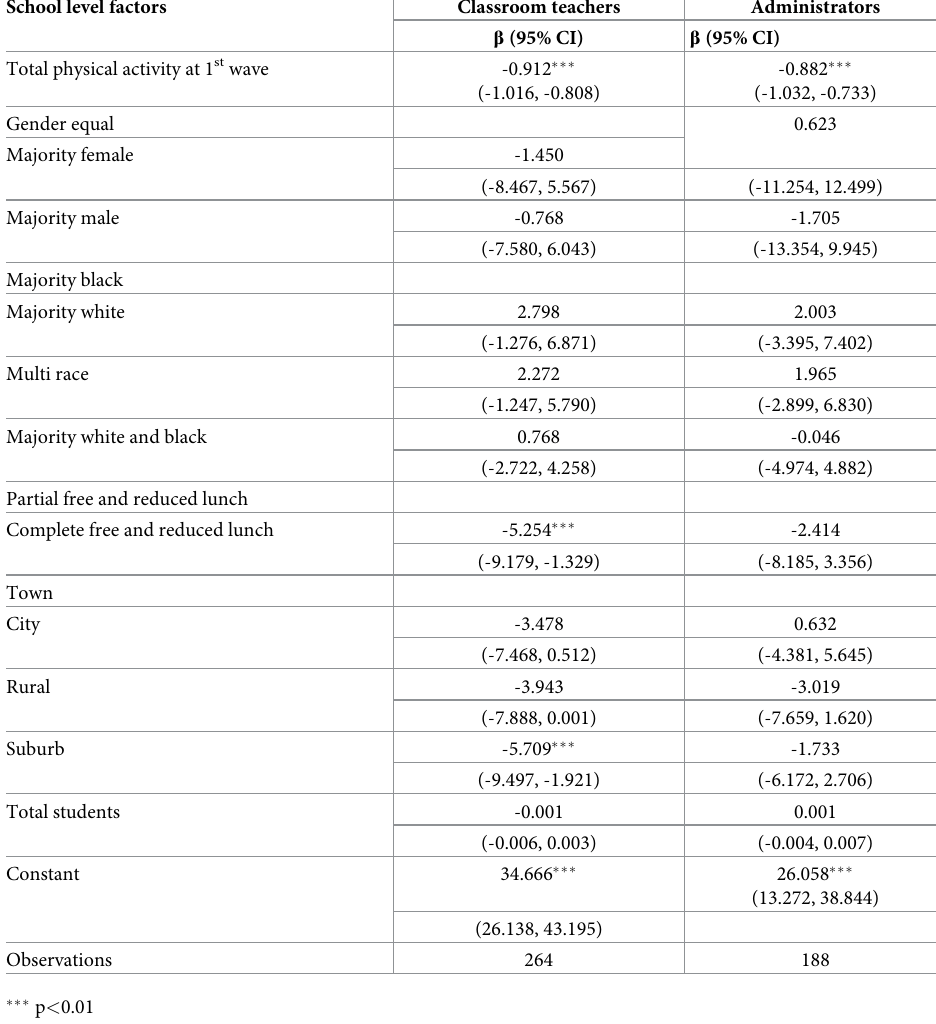
Table 4. Beta coefficients from multiple linear regression with change in total physical activity time (1 st to 2 nd wave) regressed on school level